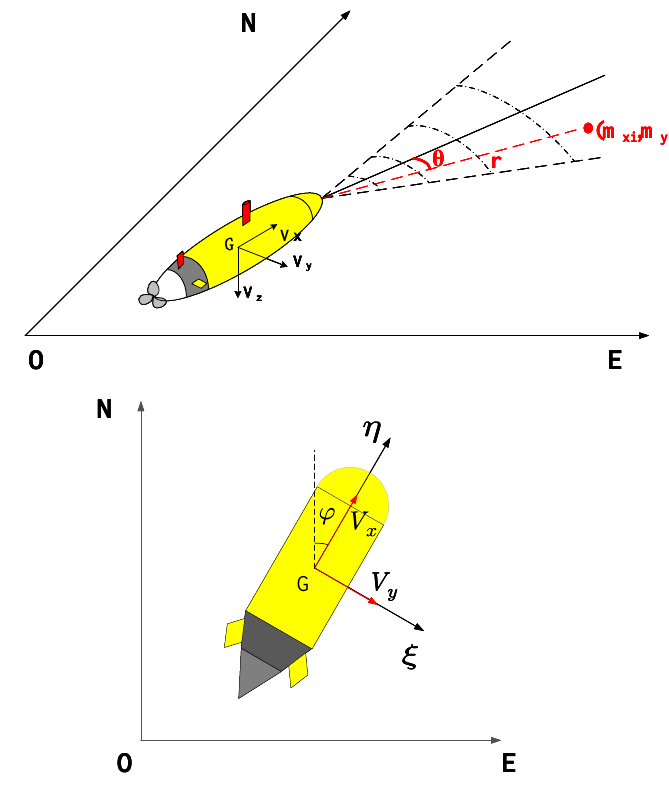
Figure 2. Navigation coordinate system of Sailfish